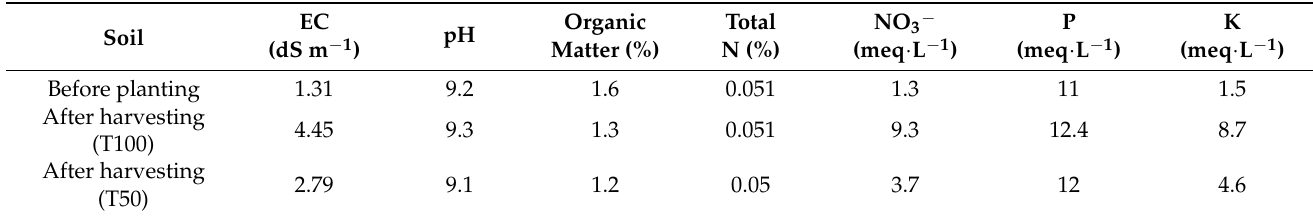
Table 1. Saturated extract soil